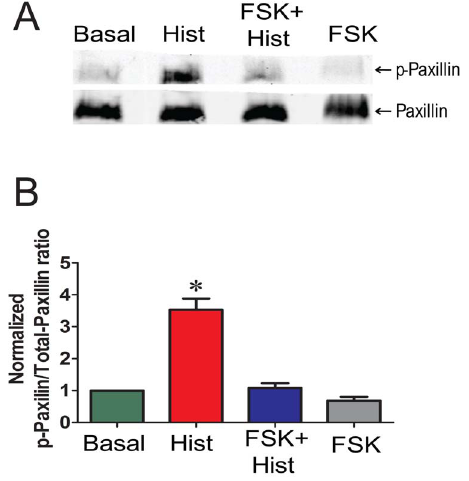
Figure 8. Preincubation with forskolin abolish histamine induced paxillin phosphorylation in PCA. Conditions are the same as described in Figure 3. Proteins were extracted and separated on SDS polyacrylamide gels and p-paxillin and np- paxillin were detected by western blotting. Panel A: Representative western blot of p-paxillin and np-paxillin. Panel B: Cumulative data representing the relative amounts of p-paxillin over total paxillin and normalized to the basal. Quantitative values were obtained when the phosphorylated and non-phosphorylated paxillin bands were quantitated densitometrically n=4. p , 0.05. *significant compared to all other